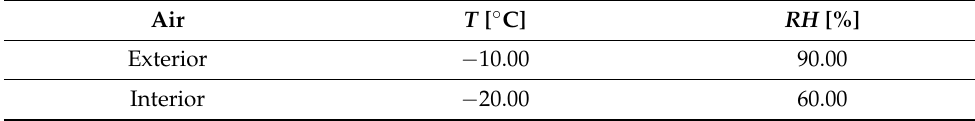
Table 4. Air temperature and relative humidity